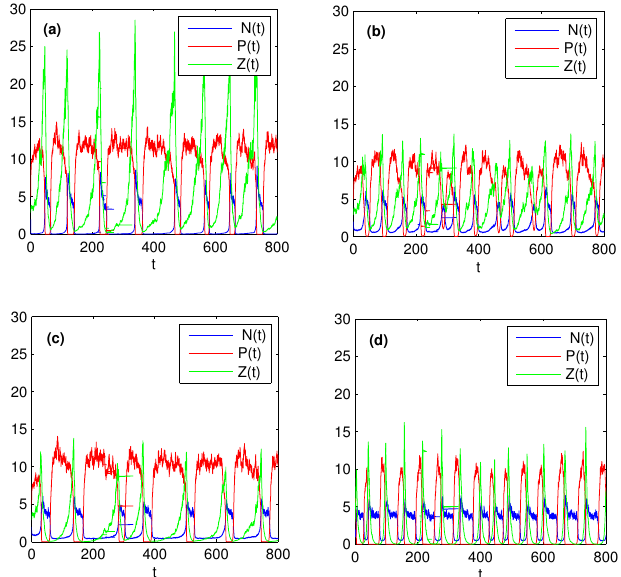
Figure 4. Effects of nonlinear uptake and grazing functions on the population persistence in stochastic environment. Here, σ 1 = 0.1, σ 2 = 0.05, σ 3 = 0.08. ( a ) k = 0.2, λ = 0.5, δ = 0.5; ( b ) k = 1.8, λ = 0.5, δ = 0.5; ( c ) k = 1.8, λ = 1, δ = 0.5; ( d ) k = 1.8, λ = 1, δ = 1. All the other parameters are the same as Figure